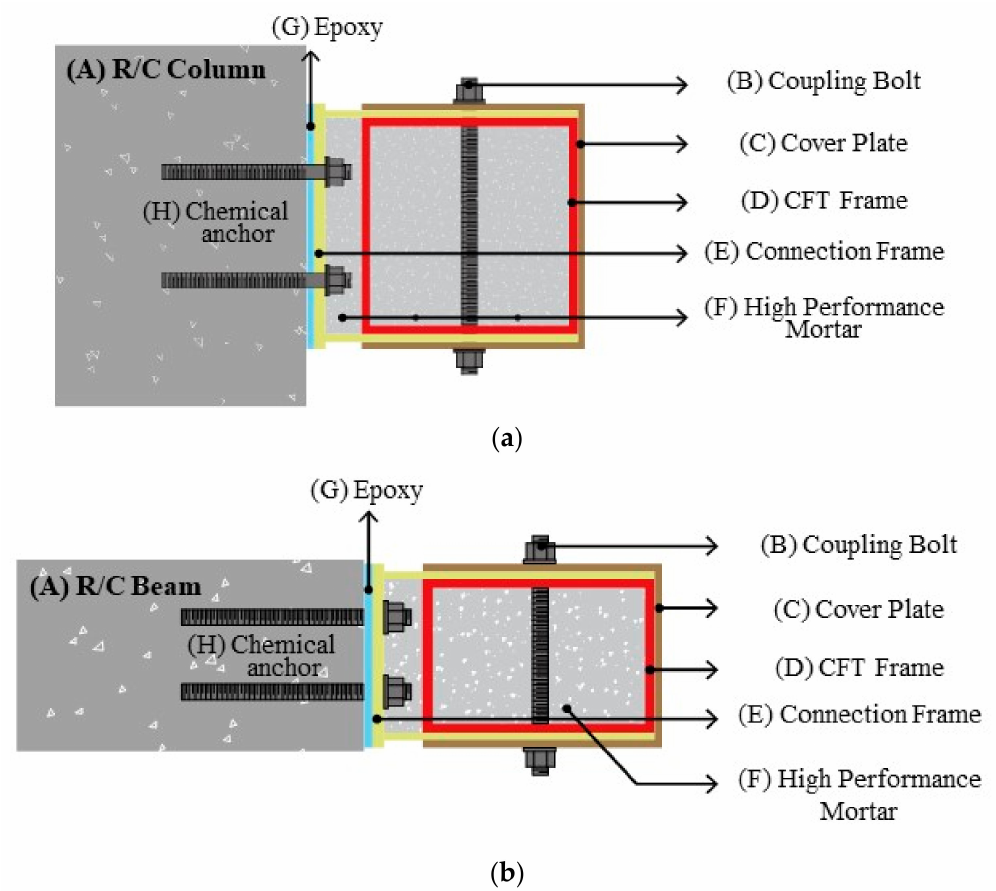
Figure 5. Connection details of CFT-MF system: ( a ) existing column and CFT-MF and ( b ) existing beam and